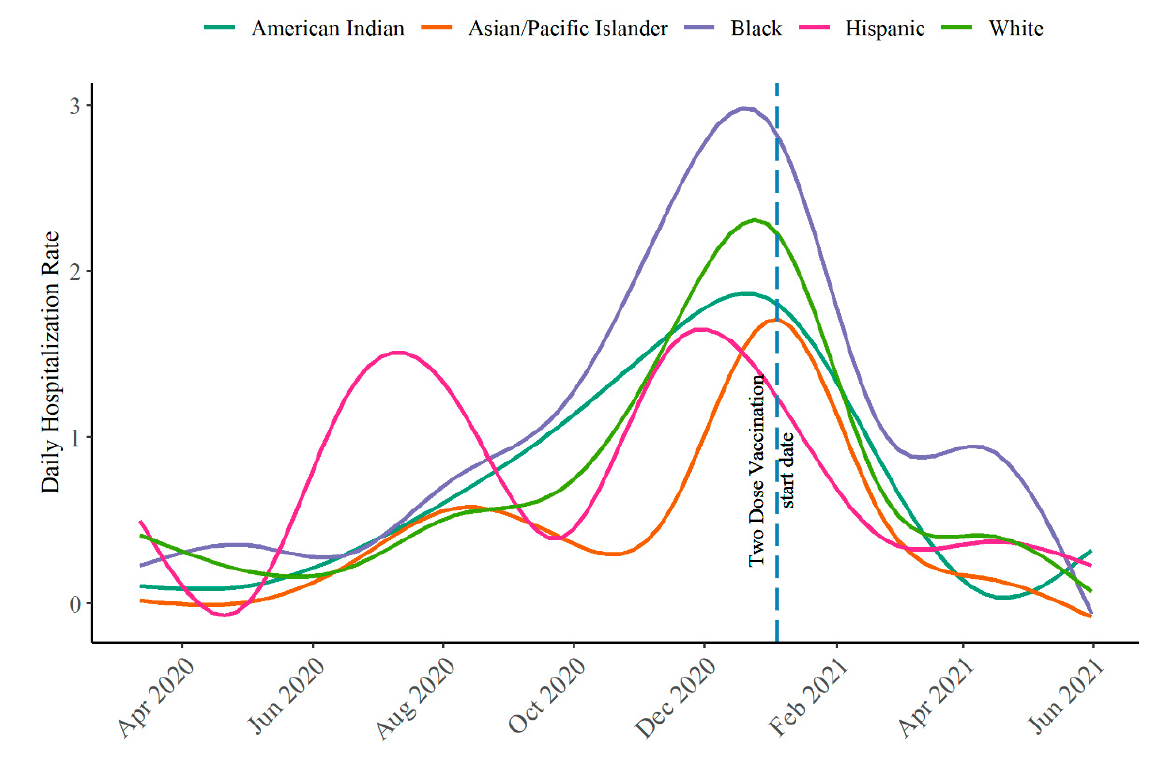
Figure 1. The 7-day average of daily hospitalization rate per 100,000 population smoothed trend lines stratified by race/ethnicity in Oklahoma City–County, 12 March 2020–31 May 2021. The vertical dashed line indicates the first date by which an Oklahoma City–County resident could have received two COVID-19 vaccine doses.